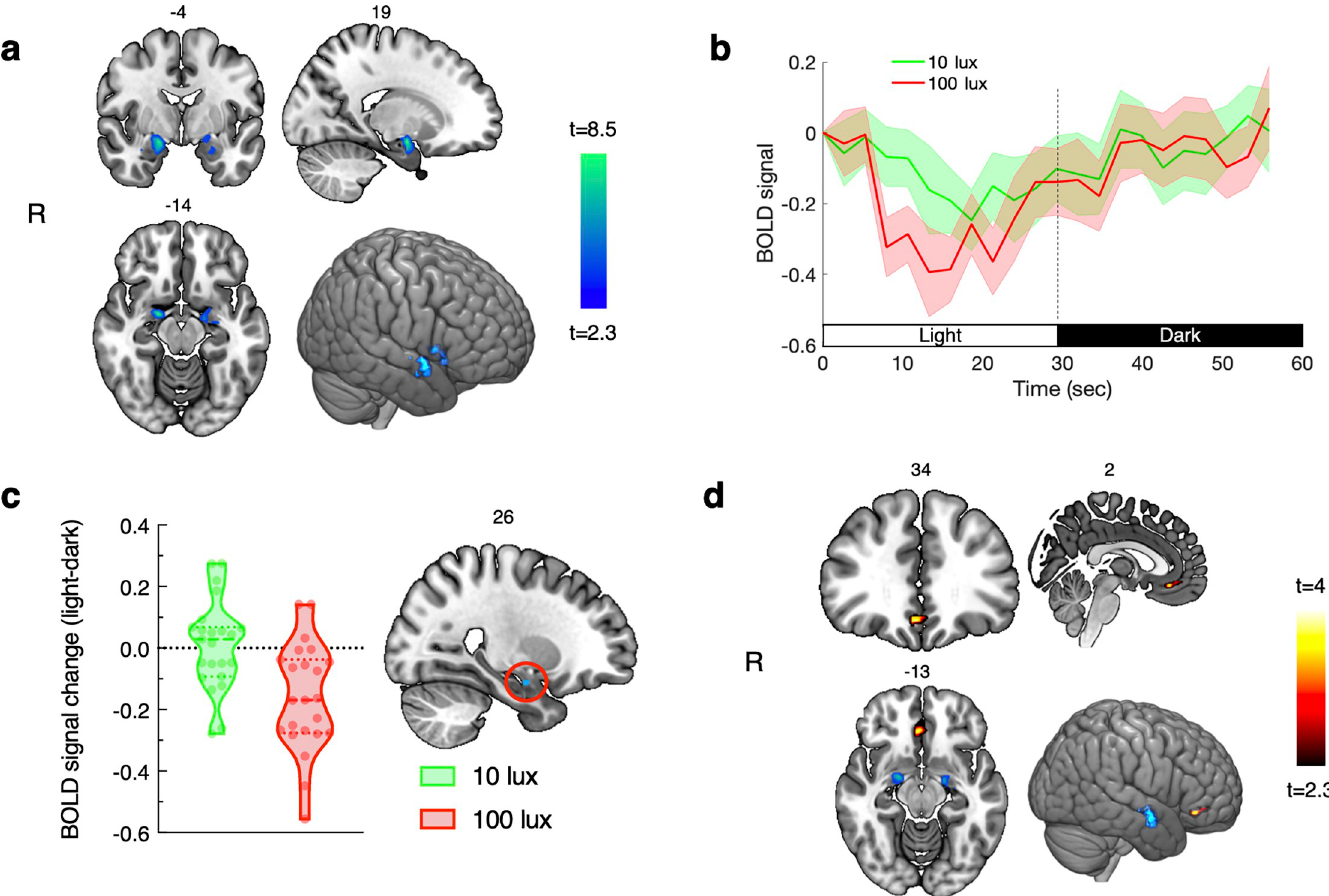
Fig 1. Light, compared with dark, decreased activation in the amygdala and increased functional connectivity between the amygdala and ventro-medial prefrontal cortex. (a) Voxels with significantly decreased activity in the amygdala during light relative to dark ( p < 0.05, small volume correction using bilateral amygdala mask); (b) average time-course of the baseline-corrected BOLD signal across individuals (shaded areas represent SEM). Time-courses were obtained by averaging the normalized BOLD signal for the 8 cycles each of light and dark periods from significant voxels within the amygdala; (c) BOLD signal % change in the cluster (4 voxels) showing greater deactivation during 100 lux compared with 10 lux ( p < 0.05, cluster corrected within the bilateral amygdala mask). The peak voxel was located at MNI: 25, -7, 19. Individual responses are represented by circles, and dashed and dotted lines represent the median and upper/lower quartiles, respectively; and (d) voxels (53 voxels) within the vmPFC mask showing a significant interaction effect for light vs . dark for functional connectivity with the amygdala ( p < 0.05, cluster corrected within the vmPFC mask). The peak voxel was located at MNI: 2, 35, -14. Note : Slice labels in panels a, c, and d denote MNI slice numbers. Activation maps are shown on an MNI template and visualized using MRICroGL software using radiological